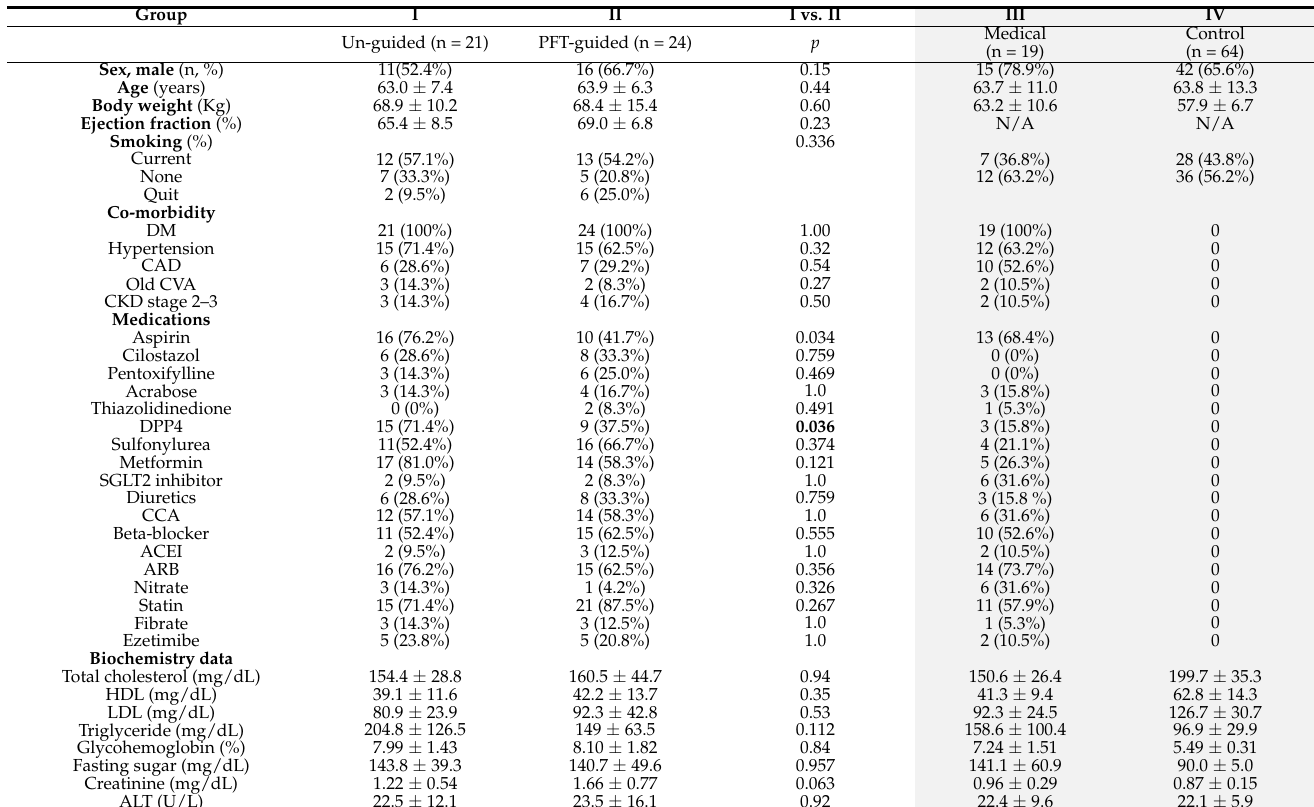
Table 1. Baseline characteristics of diabetic patients with peripheral artery disease who were randomly assigned into the un-guided (Group I), the PFT-guided (Group II) group and those who refused intervention (Group III). These are compared with age- and sex-matched healthy participants (Group IV) recruited from the Northeastern Taiwan Community Medicine Research Cohort.